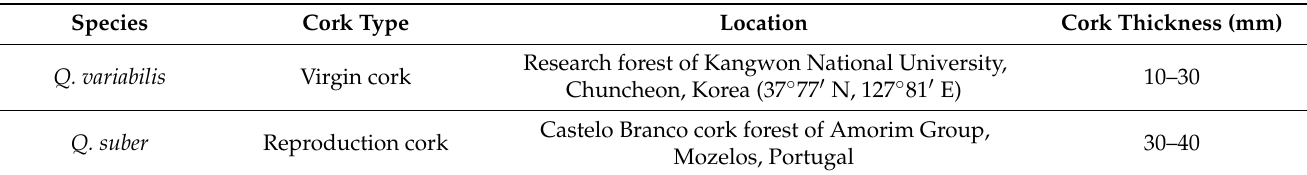
Figure 1. Q. variabilis virgin cork ( A ) and Q. suber reproduction cork ( B ). Black scale bar represents 20 mm. Table 1. Basic information of the sample cork.